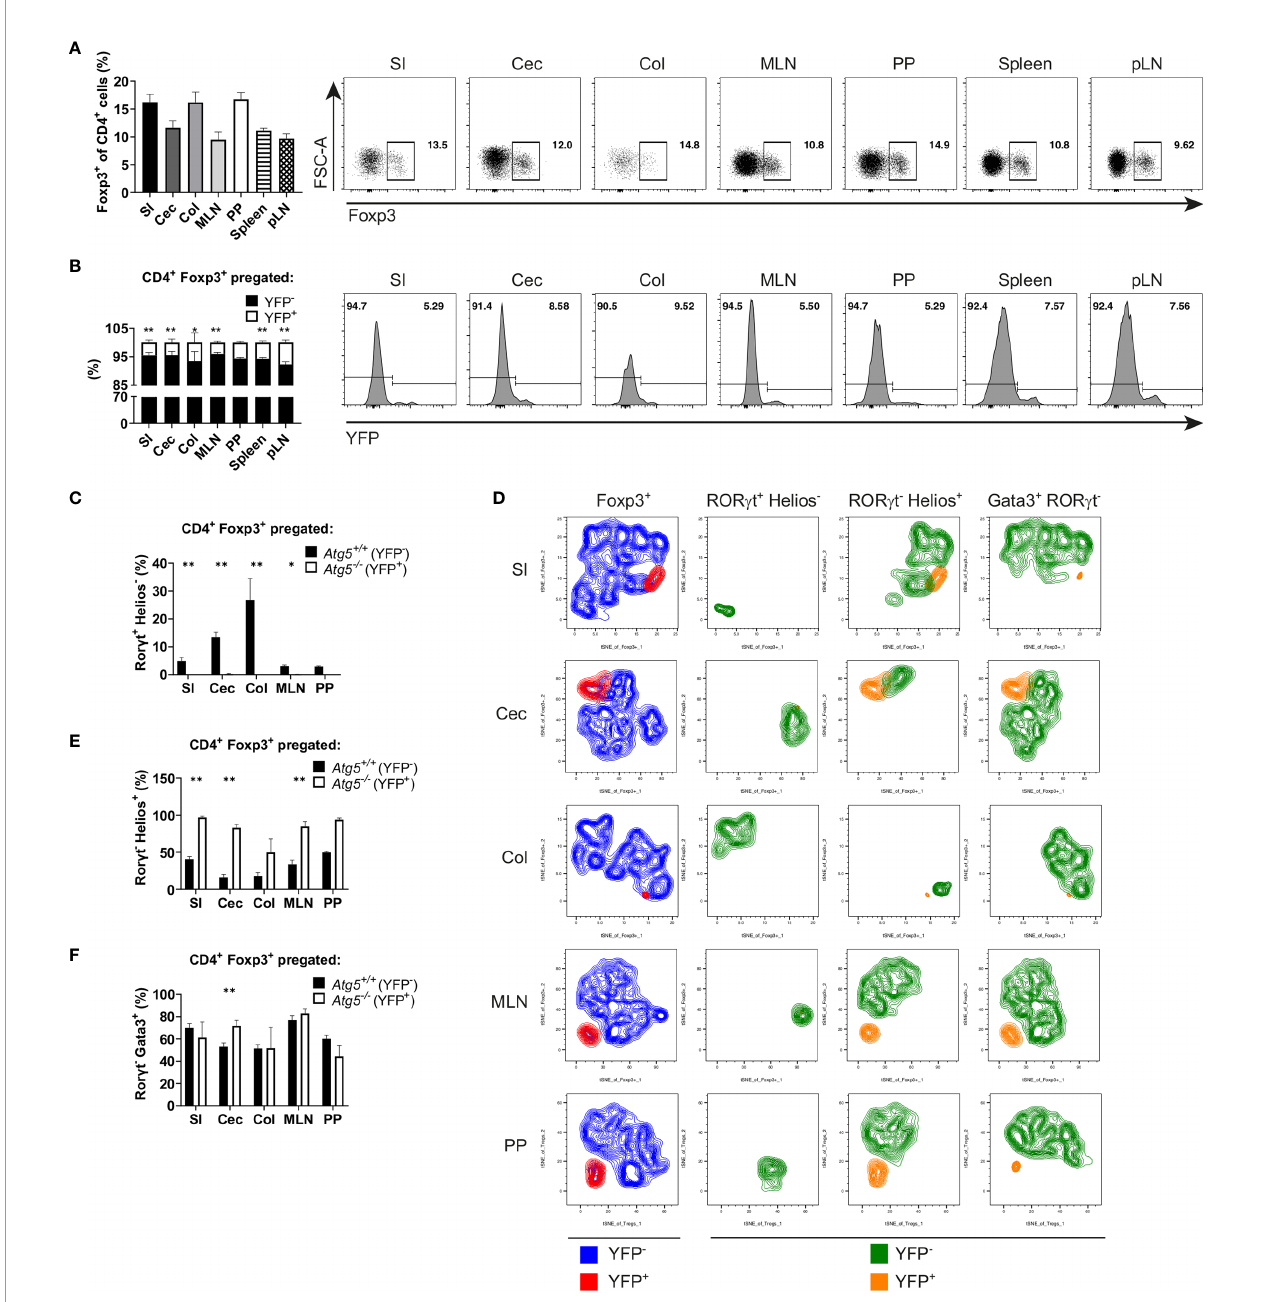
FIGURE 6 | Atg5 is crucial to preserve the intestinal Foxp3 + ROR g t + Treg cell population. (A) Bar graph (left) and representative dot plots (right) of Foxp3 + cell frequencies within CD4 + cells of small intestine (SI), cecum (Cec), colon (Col), mesenteric lymph nodes (MLN), Peyer´s patches (PP), spleen and peripheral lymph nodes (pLN) of Atg5 fl / fl Foxp3 Cre/wt mice. (B) Bar graph (left) and representative dot plots (right) of YFP - and YFP + distribution within the CD4 + Foxp3 + cells of small intestine (SI), cecum (Cec), colon (Col), mesenteric lymph nodes (MLN), Peyer´s patches (PP), spleen and peripheral lymph nodes (pLN) of Atg5 fl / fl Foxp3 Cre/wt mice. (C) Atg5-pro fi cient (YFP - ) and Atg5-de fi cient (YFP + ) frequencies within the ROR g t + Helios - Treg cells in small intestine (SI), cecum (Cec), colon (Col), mesenteric lymph nodes (MLN) and Peyer´s patches (PP) of Atg5 fl / fl Foxp3 Cre/wt mice. (D) tSNE plots of YFP - and YFP + cell distribution within the Foxp3 + , ROR g t + Helios - , ROR g t - Helios + and ROR g t - Gata3 + cells in small intestine (SI), cecum (Cec), colon (Col), mesenteric lymph nodes (MLN) and Peyer´s patches (PP) of Atg5 fl / fl Foxp3 Cre/wt mice. (E) Atg5-pro fi cient (YFP - ) and Atg5-de fi cient (YFP + ) frequencies within the ROR g t - Helios + Treg cells in small intestine (SI), cecum (Cec), colon (Col), mesenteric lymph nodes (MLN) and Peyer´s patches (PP) of Atg5 fl / fl Foxp3 Cre/wt mice. (F) Atg5-pro fi cient (YFP - ) and Atg5-de fi cient (YFP + ) frequencies within the ROR g t - Gata3 + Treg cells in small intestine (SI), cecum (Cec), colon (Col), mesenteric lymph nodes (MLN) and Peyer´s patches (PP) of Atg5 fl / fl Foxp3 Cre/wt mice. (B, C, E, F) Statistical analyses were performed by two-tailed Mann-Whitney tests. Mean ± SEM are given. (SI, n=6; Cec, n=6; Col, n=4, MLN, n=5; PP, n=3; Spleen, n=6; pLN, n=6; data obtained from two independent experiments). *p < 0.05, **p <